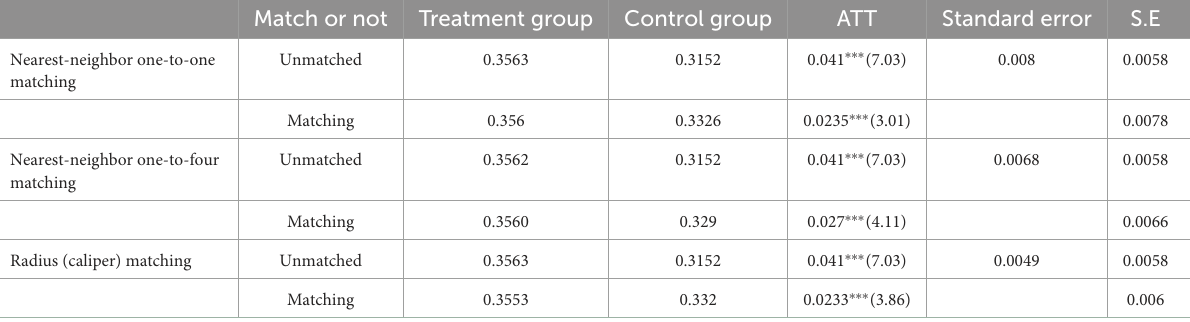
TABLE 6 Propensity score match results.